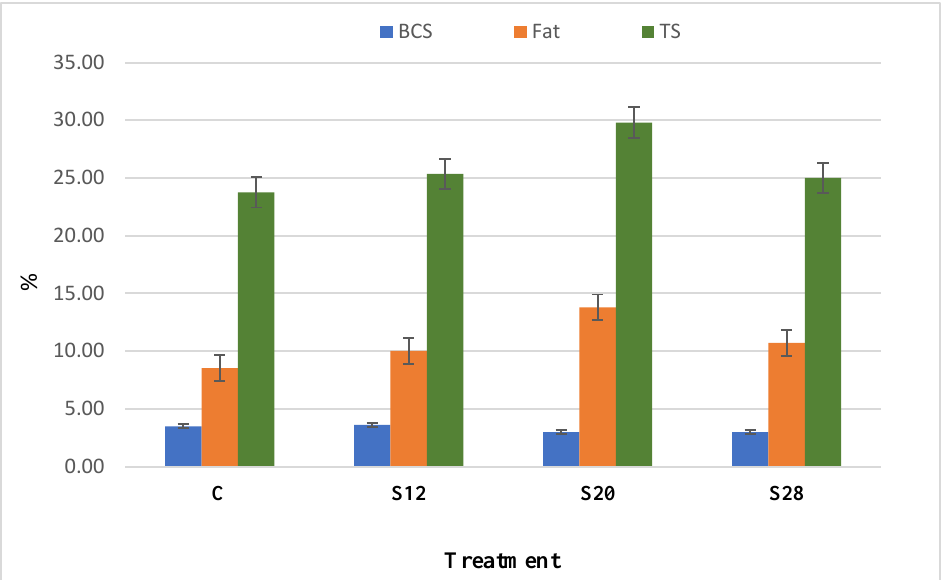
Figure 1. The relationship between the body condition score, colostrum fat, and colostrum total solid (TS) of ewes fed a complete diet with different levels of sunflower hulls.